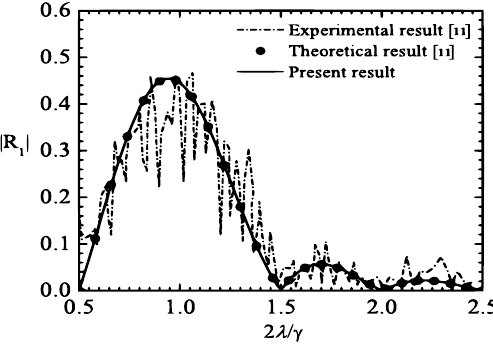
Figure 2. | R 1 | for ρ 1 = ρ 2 ,m = n = 2 ,a/ ( h + H ) = 0 . 32 ,M/h 2 = 0 ,Gh =